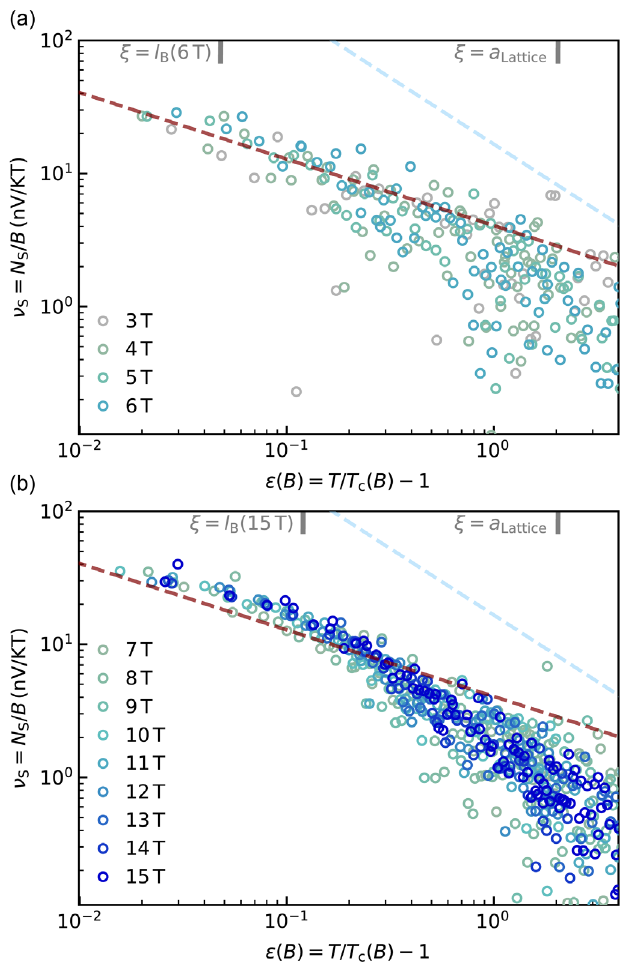
FIG. 5. Scaling of the superconducting Nernst coefficient above T c . (a) Quasiparticle-subtracted contribution to the Nernst co- S , for magnetic fields be- efficient, ν S ¼ N S =B ¼ N=B þ 2 . 7 μ H tween 3 T and 6 T. Color scale as in Fig. 1. The data are shown as a function of the distance to the field-dependent critical temper- ature at zero field. (b) Data for higher fields, up to 15 T. The dashed red line shows the expected low-field value from a model based on three-dimensional Gaussian fluctuations, which scales with ϵ − 1 = 2 . A constant conductivity of 6 ð m Ω cm Þ − 1 is used (see text). The dashed blue line shows the equivalent signal for a two- dimensional system, which scales with ϵ − 1 . The top axes indicate where the correlation length ξ becomes equal to the lattice spacing a or to the magnetic length l B at the highest field Lattice shown in the respective